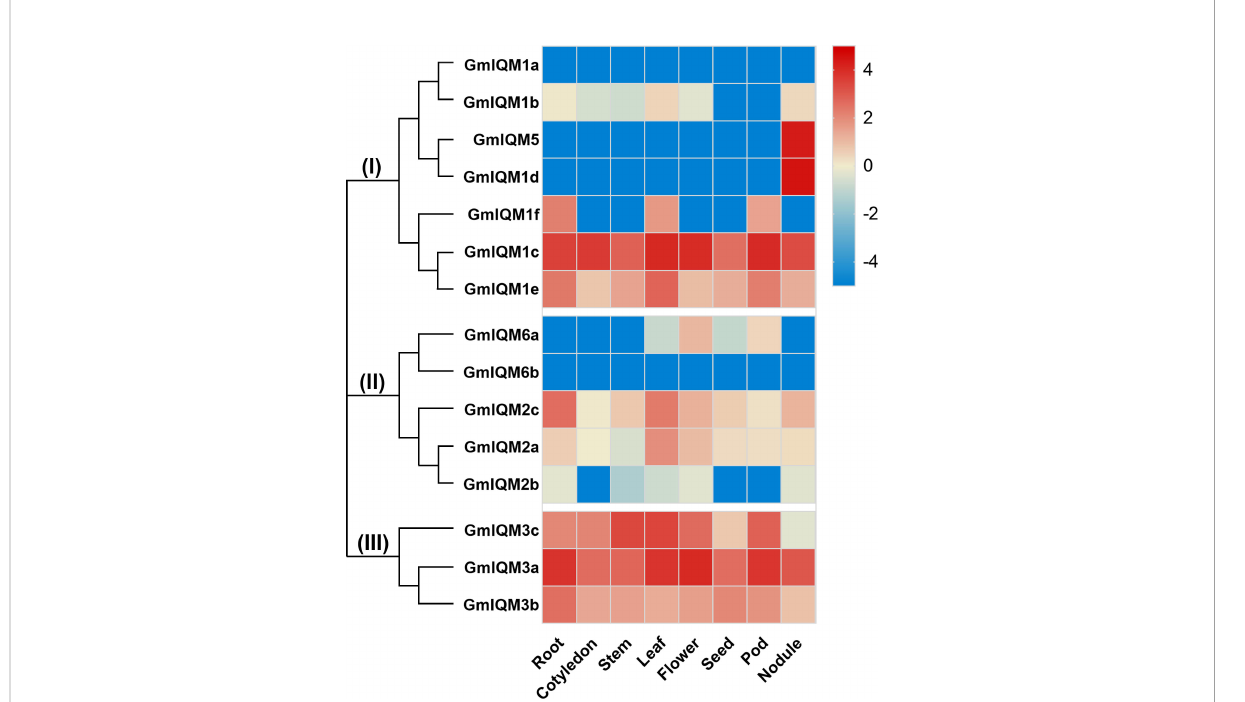
FIGURE 7 Heat map of real-time quantitative PCR analysis results of GmIQM in eight tissues.Total RNA was extracted from roots, cotyledons, stems, leaves, fl owers, pods, and nodules. Each sample was collected from fi ve independent plants, independent biological assays were repeated three times, and similar results were obtained. Data from one representative replicate are shown. Values are means average from three technical measurements. Color scale at the right side of the image represents log10 of the gene expression values. Red indicates high expression level and blue indicates low expression level.